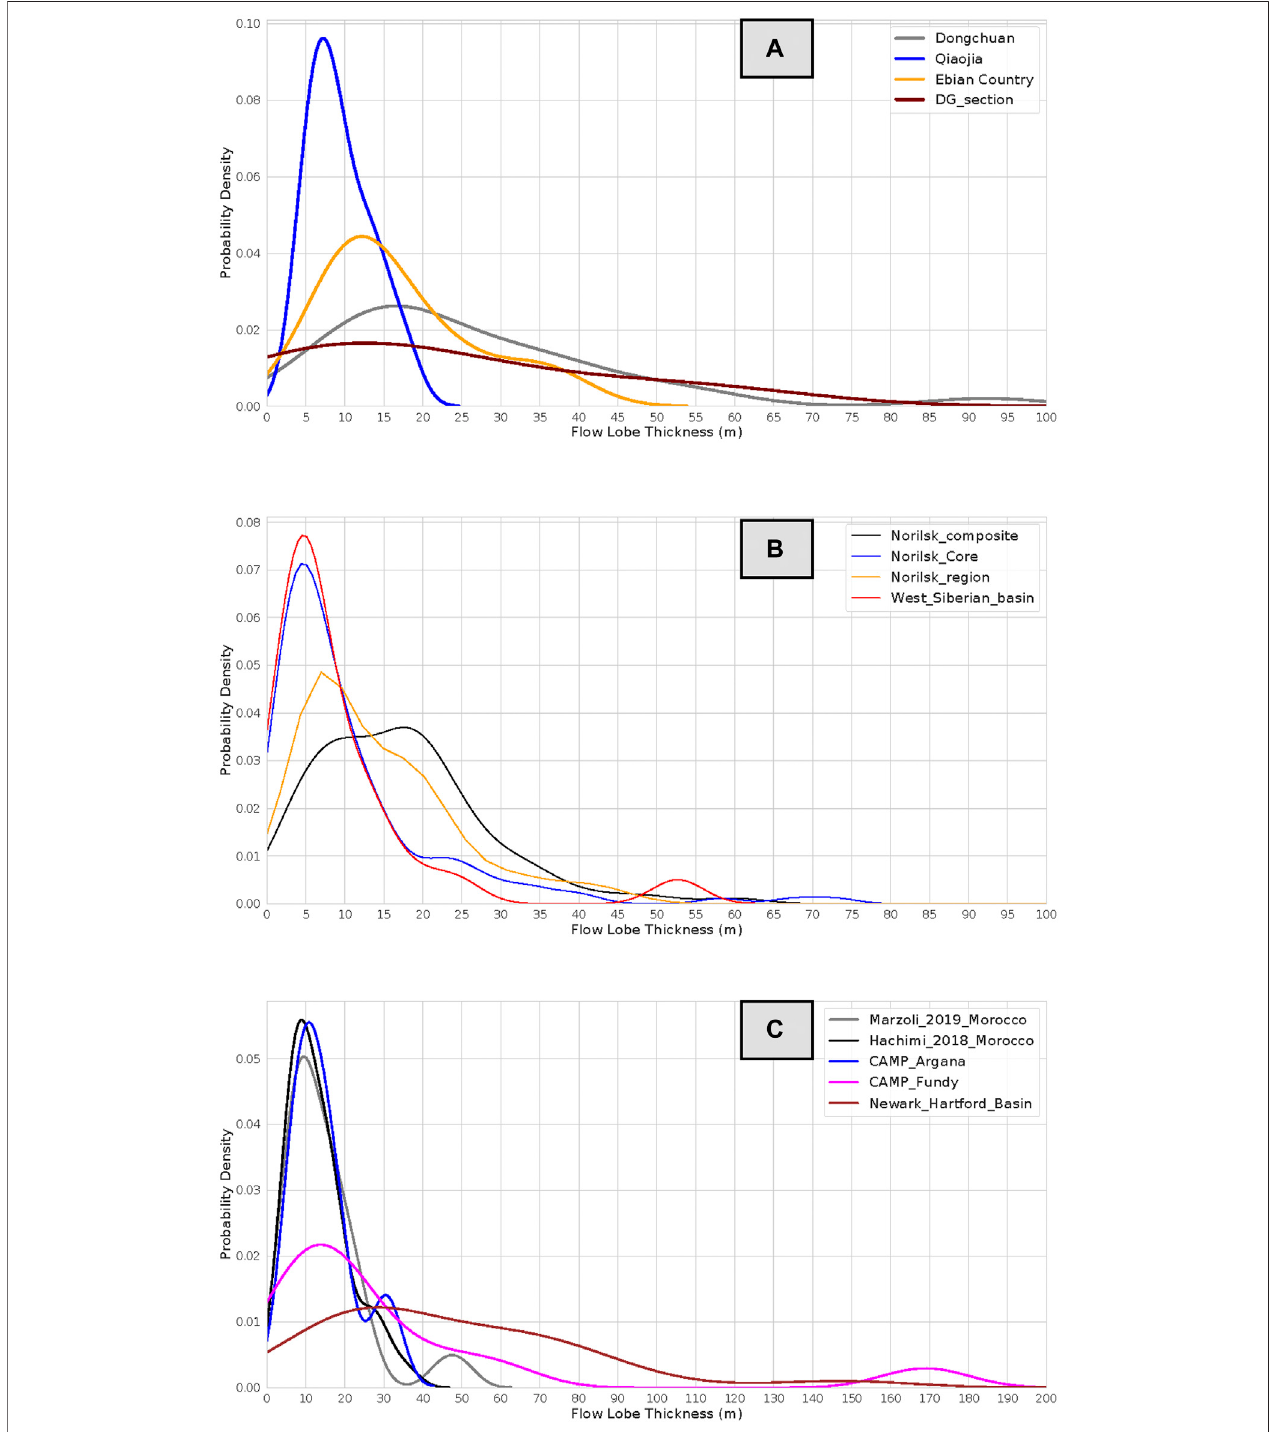
FIGURE 9 | (A) Plot of univariate kernel density estimators to calculate PDF of lobe thicknesses for lavas of Emeishan CFB Province, China, from 4 different areas; see text for details. (B) Plot of univariate kernel density estimators to calculate PDF of lobe thicknesses for lavas from Siberian CFB Province, Russia; see text for details. (C) Plot of univariate kernel density estimators to calculate PDFs of lobe thicknesses for lavas of CAMP Province in Morocco (including Argana Basin) and NE North America (Newark and Fundy Basins).